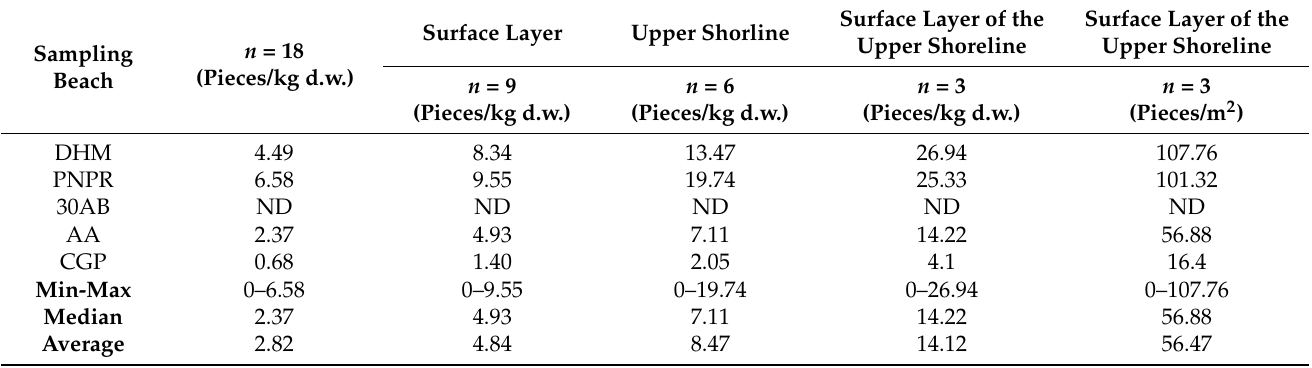
Figure 2. Abundance of microplastics in Can Gio, Ho Chi Minh City, in 2019. ( a ) Abundance of microplastics of different beaches; ( b ) abundance of macroplastics of different beaches; ( c ) abundance of microplastics at different tidal lines; ( d ) abundance of microplastics at different depths. Table 2. Abundance of microplastics (quantity and mass) in the surface layer and upper shoreline in Table 1. Abundance of microplastics and macroplastics in beach sand samples in Can Gio, Ho Chi Minh City, Vietnam in November 2019 .